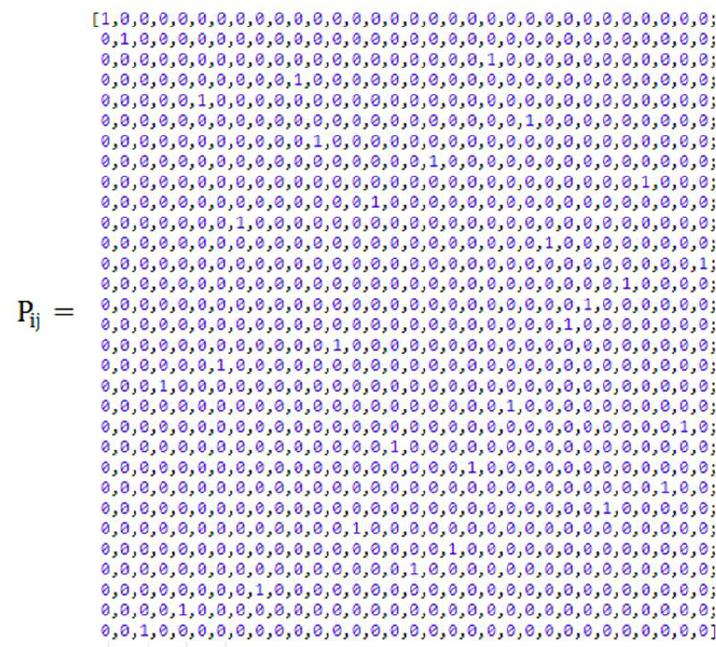
Figure A1. 32 by 32 one-to-one permutation matrix.